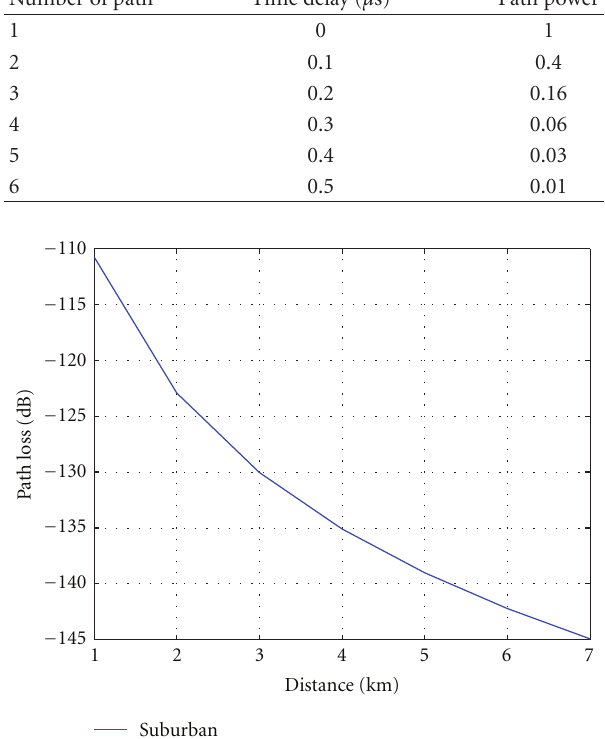
Figure 5: Change of the path loss of the signal with distance in suburban area.